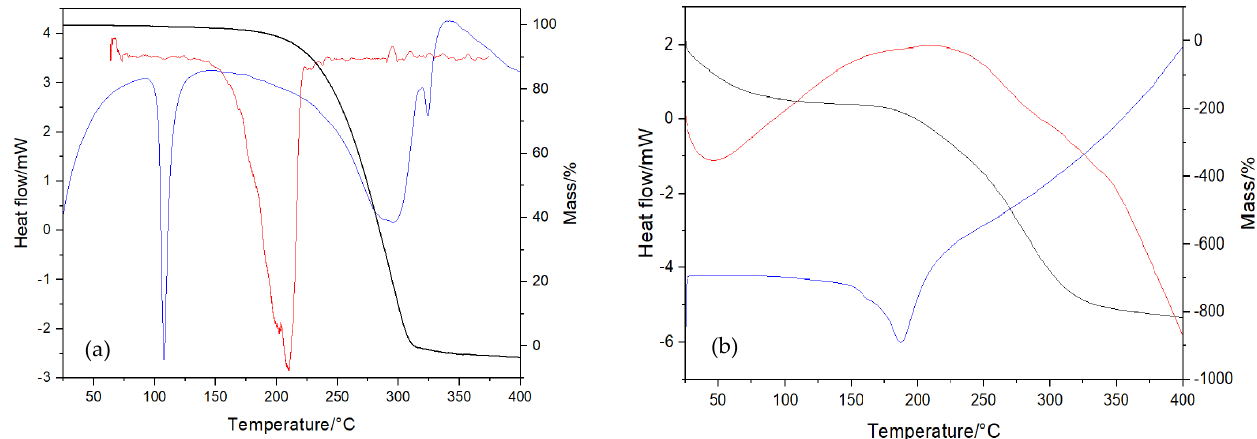
Figure 5. Thermal analysis of DTC ( a ) and MSiNP-DTC ( b ): thermogravimetry (TG) (%) (black line), differential thermal analysis (DTA) (red line), and differential scanning calorimetry (DSC) (blue line).